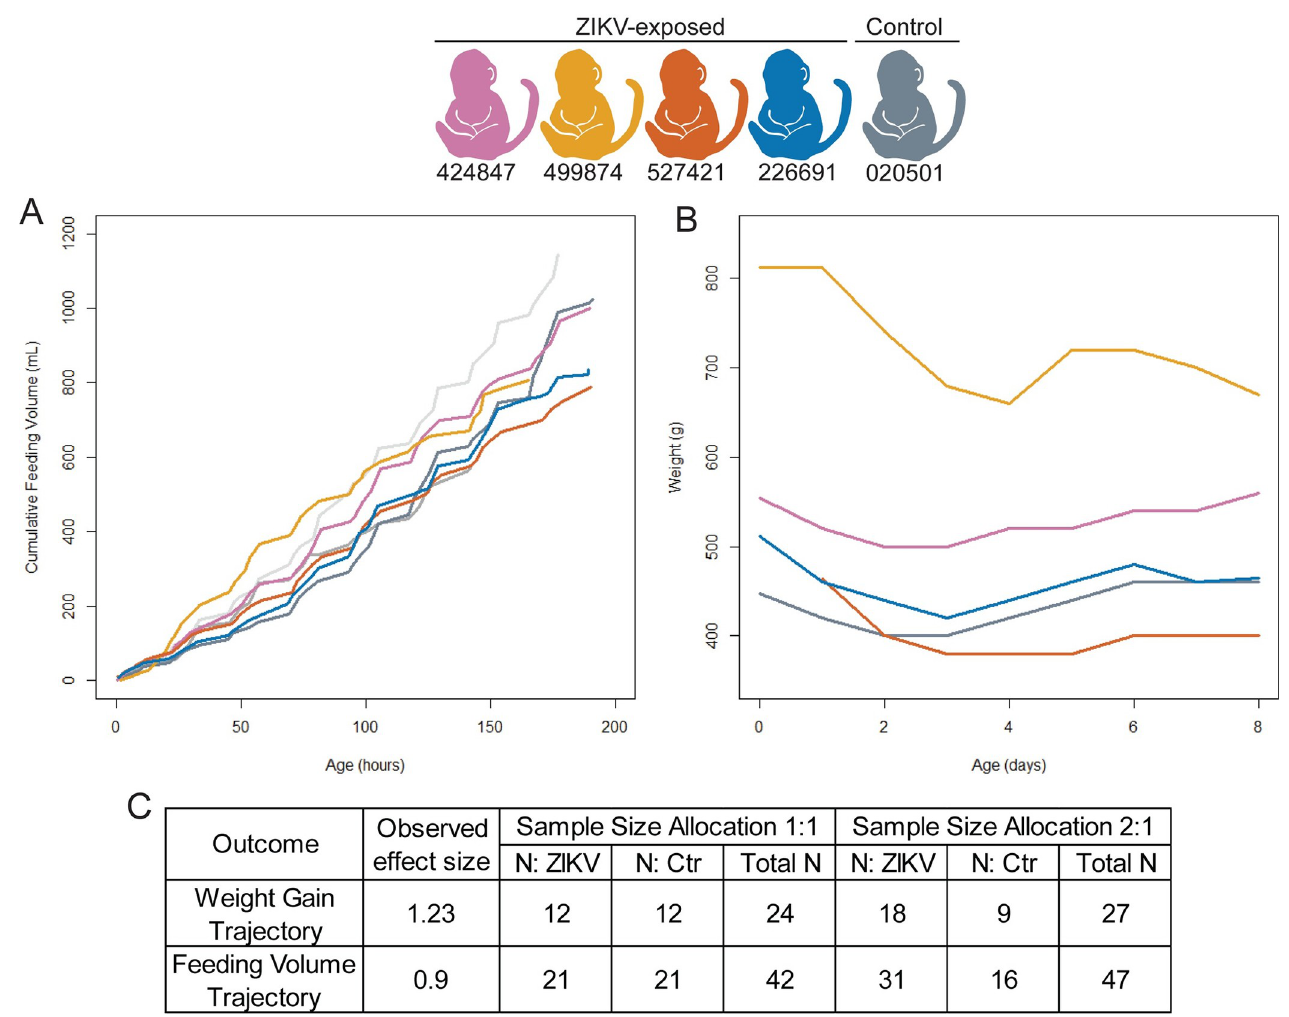
Fig 6. Infant weight gain, cumulative feeding volumes, and sample size estimates. Cumulative feeding volumes (A) and weights (B) were measured during their first week of life. Observed effect sizes and sample size requirements (C) for detecting observed effect sizes for weight gain and feeding volume trajectory with 80% power at the two-sided 0.05 significance level, assuming a sample size allocation of 1:1 and 1:2 ZIKV to control